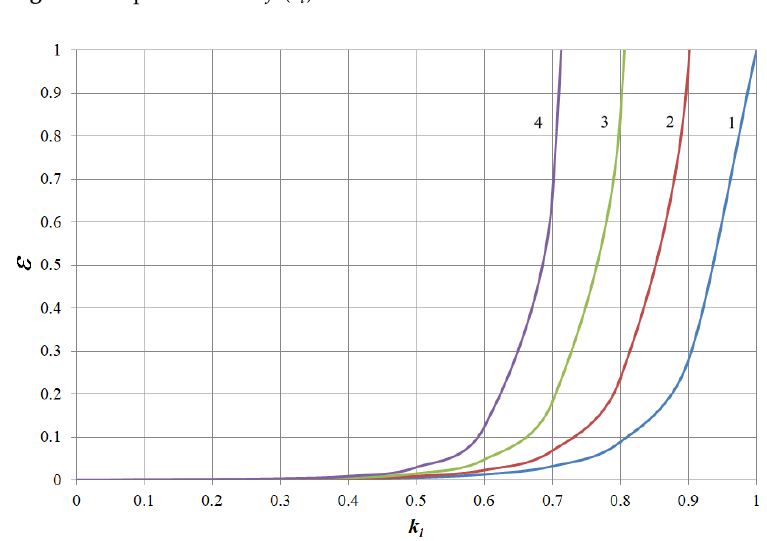
Figure 7. Dependence ε = f ( k l ) at х = 2.